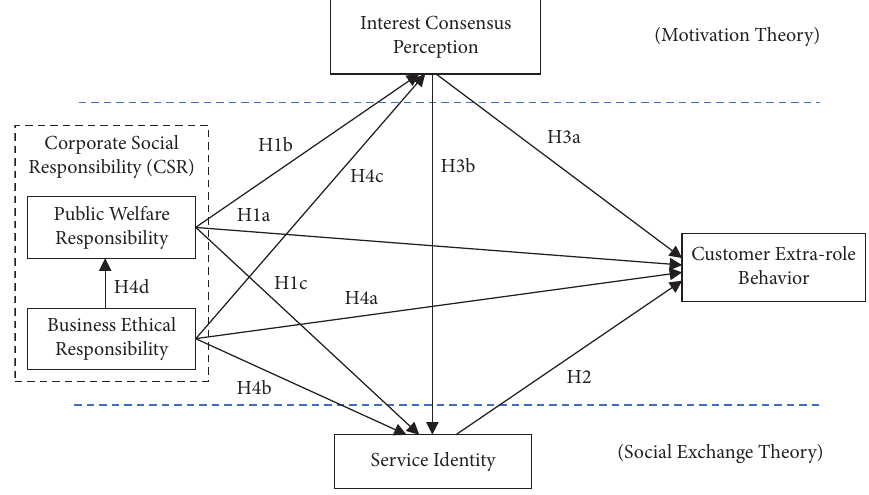
Figure 1: Research